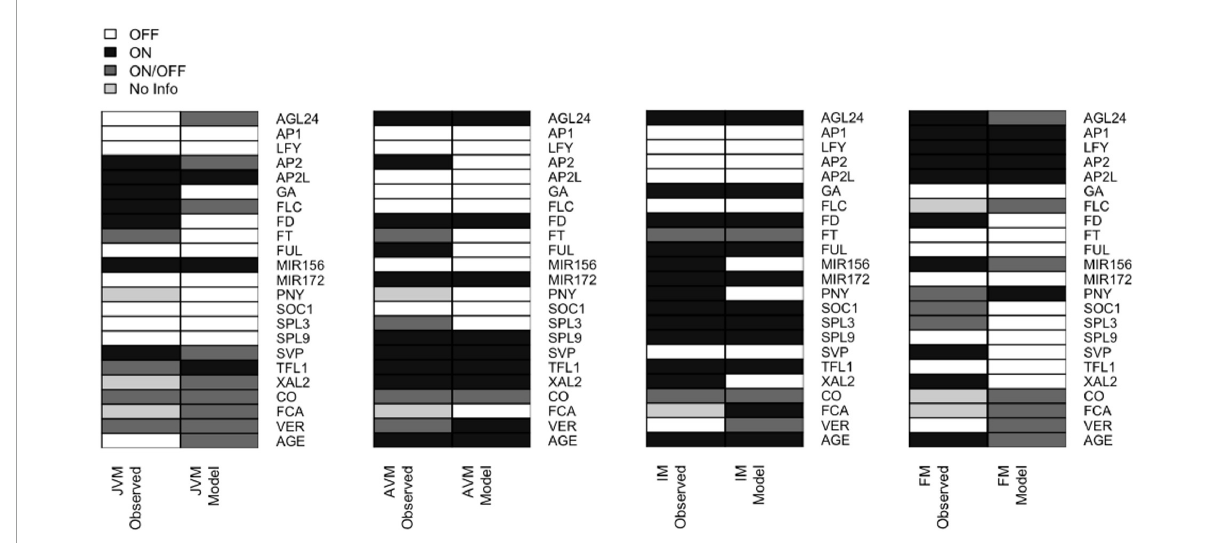
FIGURE4 The expression patterns in the attractors recovered by the FT-GRN model are like the ones observed during development. The 32 attractors recovered by the model can be classified into four phenotypes (JVM, AVM, IM, and FM). The gene expression patterns observed in planta (left) are compared to the model predicted gene expression patterns (right). The node state can be expressed/active (ON, black) or not expressed/inactive (OFF, white); or can be in either state ON or OFF (dark gray); the unknown expression patterns were label as “No Info” (pale gray). For individual attractors’ information, see Supplementary Figure 3 , and for references of gene expression patterns in planta consult Supplementary Table 5